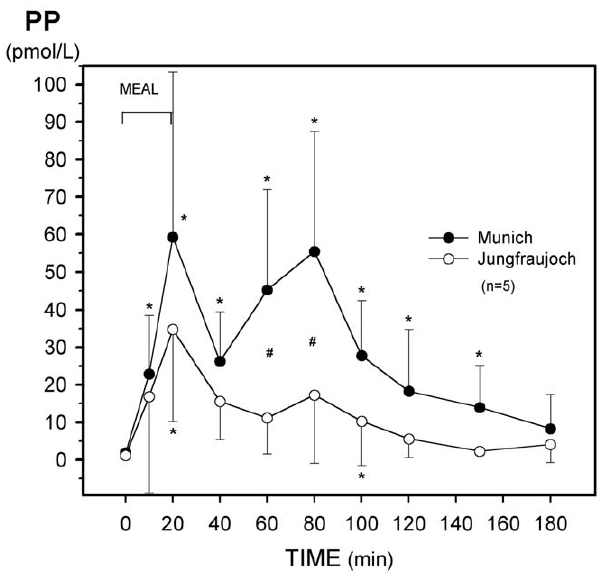
Figure 3. Effect of acute exposure to high altitude (Munich, 490 m, to Jungfraujoch, 3454 m) on postprandial plasma levels of pancreatic polypeptide (PP). Asterisks (*) indicate a significant increase (p , 0.03) as compared with the preprandial values at 0 min and crosses ( # ) mean a significant (p , 0.03) difference between the respective values at the two sea levels.